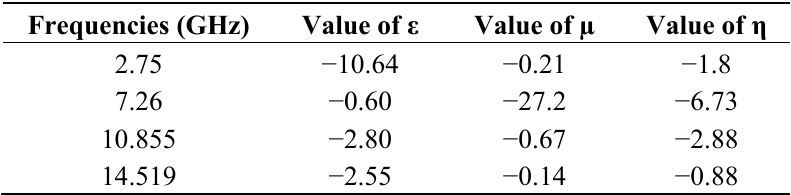
Table 3. Real values of ε, µ, and η in the desired resonance frequency bands for the 1 × 1 array of the unit